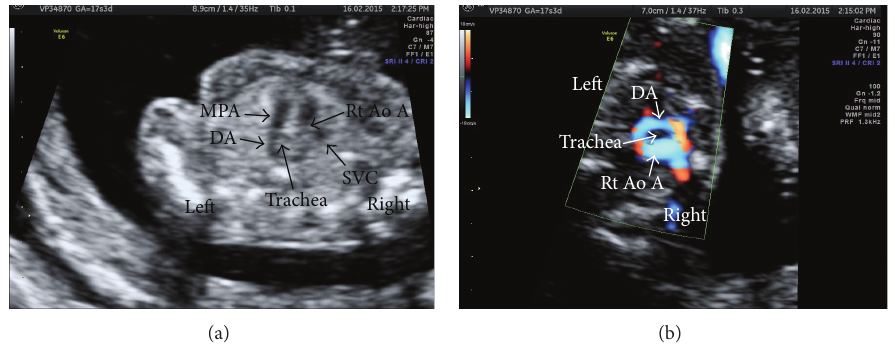
Figure 1: Fetal echocardiography at 17 weeks’ gestation. Two-dimensional gray-scale (a) and high definition color Doppler (b) images in three-vessel and trachea view. The right aortic arch (Rt Ao A) and ductus arteriosus (DA), forming classic “U” shape. MPA, main pulmonary artery; SVC, superior vena